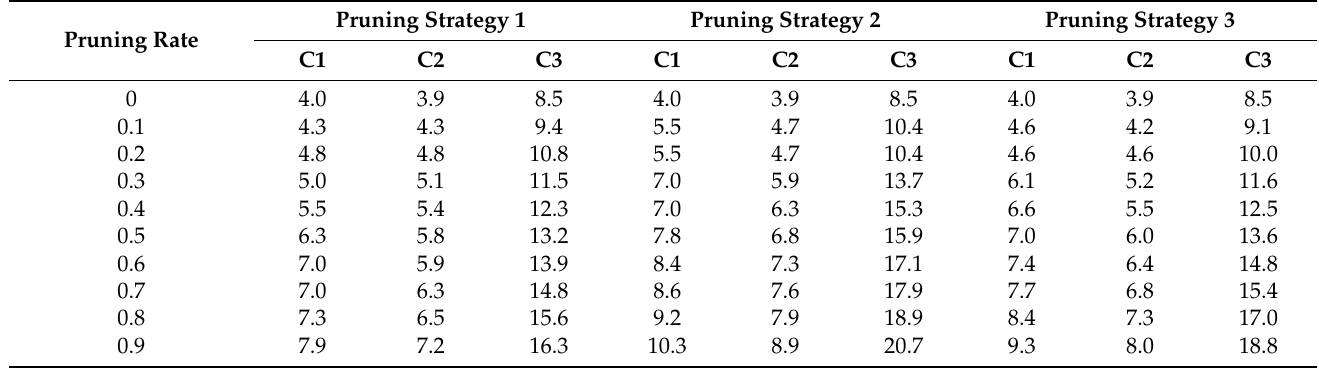
Table 7. The inference speed statistics of the pruned network model on different CPUs (/FPS). Pruning Strategy 1 Pruning Strategy 2 Pruning Strategy Pruning Rate